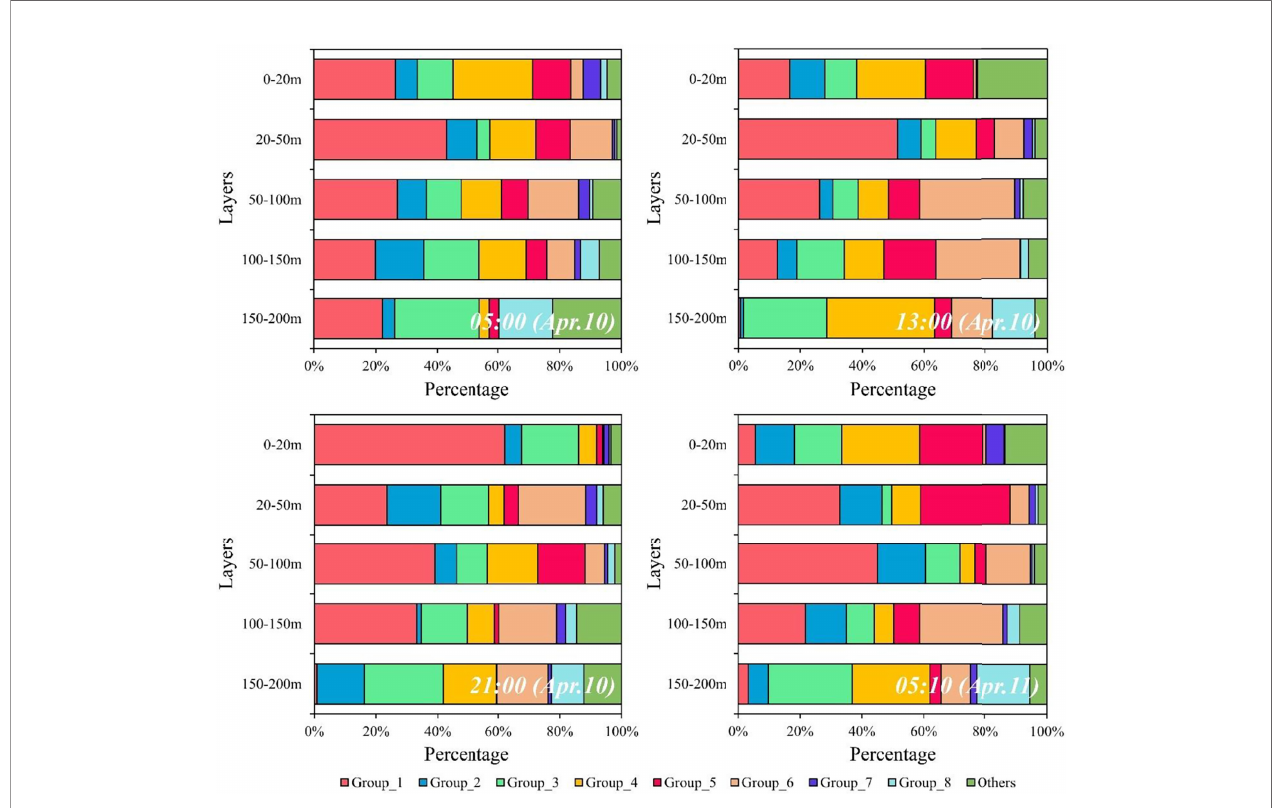
FIGURE 6 | Vertical distribution of percentage of each functional group in four sampling times.